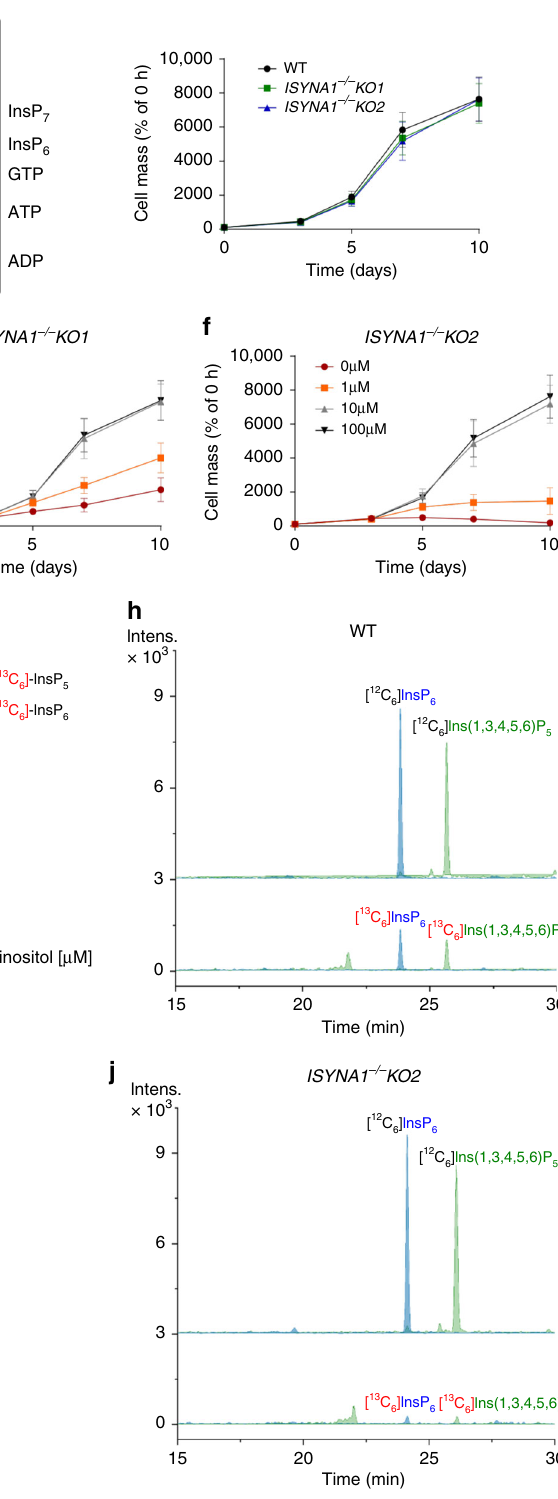
capillaries were obtained from